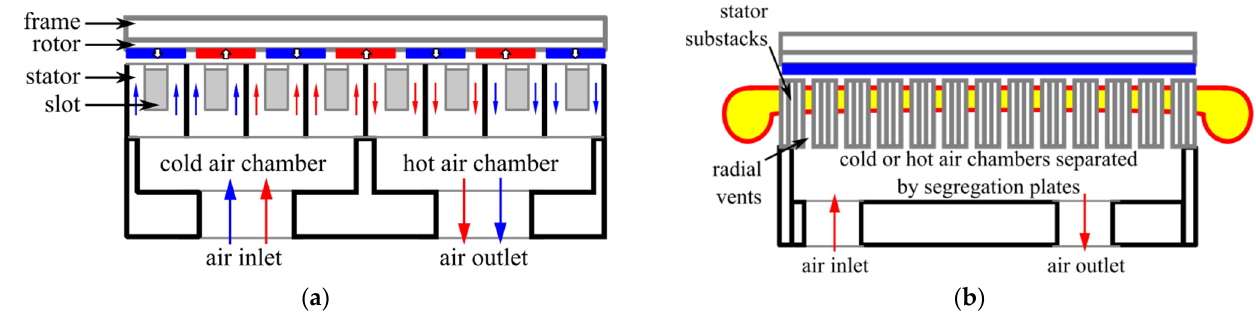
Figure 11. Radial air-cooled configuration with alternate hot and cold chamber [88]: ( a ) cross-sectional view; ( b ) longitudinal section view.